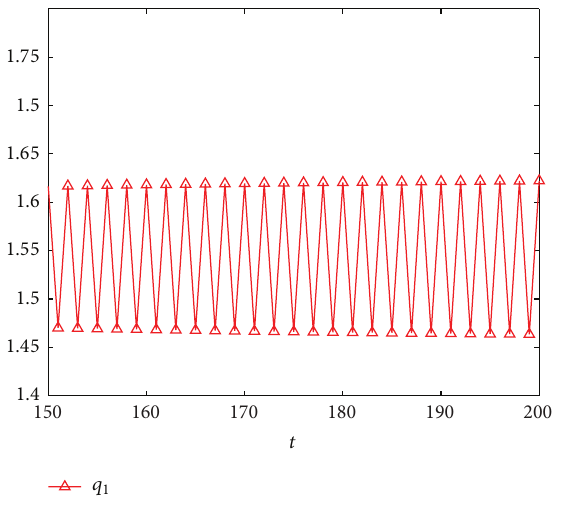
Figure 15: The wave plots of the output 𝑞 1 with the change of time when 𝛼 1 = 1.02 , 𝛼 2 = 1.46 and 𝜃 = 0.812 .